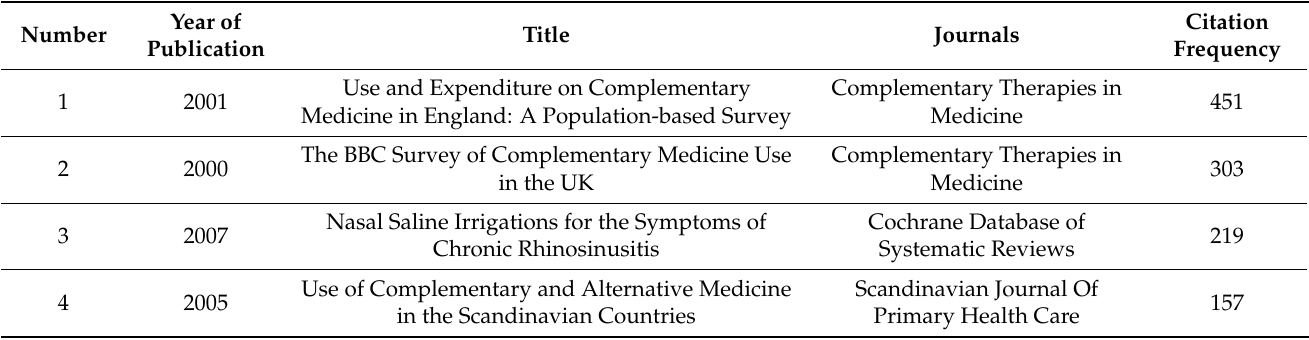
Table 4. The top 15 highly cited papers in foot reflexology (cited ≥ 100